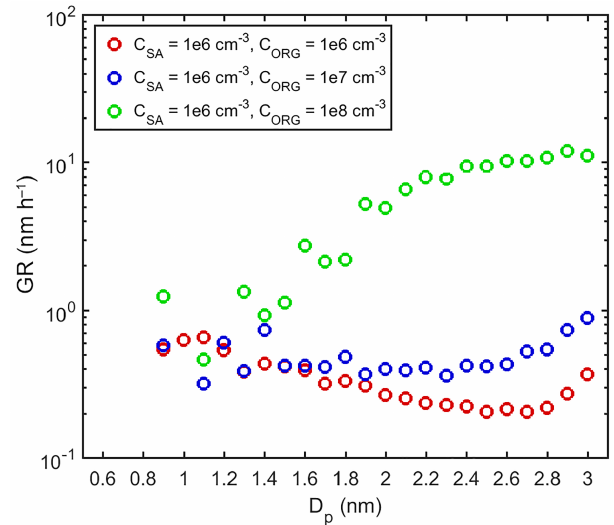
Figure 4. GRs determined for different size bins in simulations with SA–DMA and LVOC. The colors indicate vapor concentrations in each